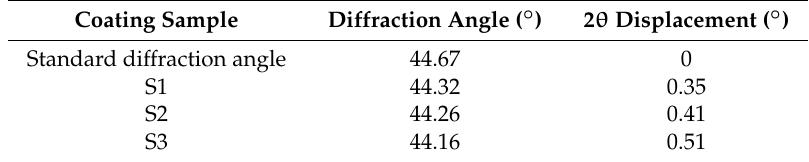
Figure 3. X-ray diffraction spectra of the laser cladded Fe-based coatings. Figure 3. X ‐ ray diffraction spectra of the laser cladded Fe ‐ based coatings. Table 3. XRD data showing variation in diffraction angle of α -Fe and 2 θ displacement. Table 3. XRD data showing variation in diffraction angle of α‐ Fe and 2 θ displacement. Coating Sample Coating Sample Diffraction Angle ( ◦